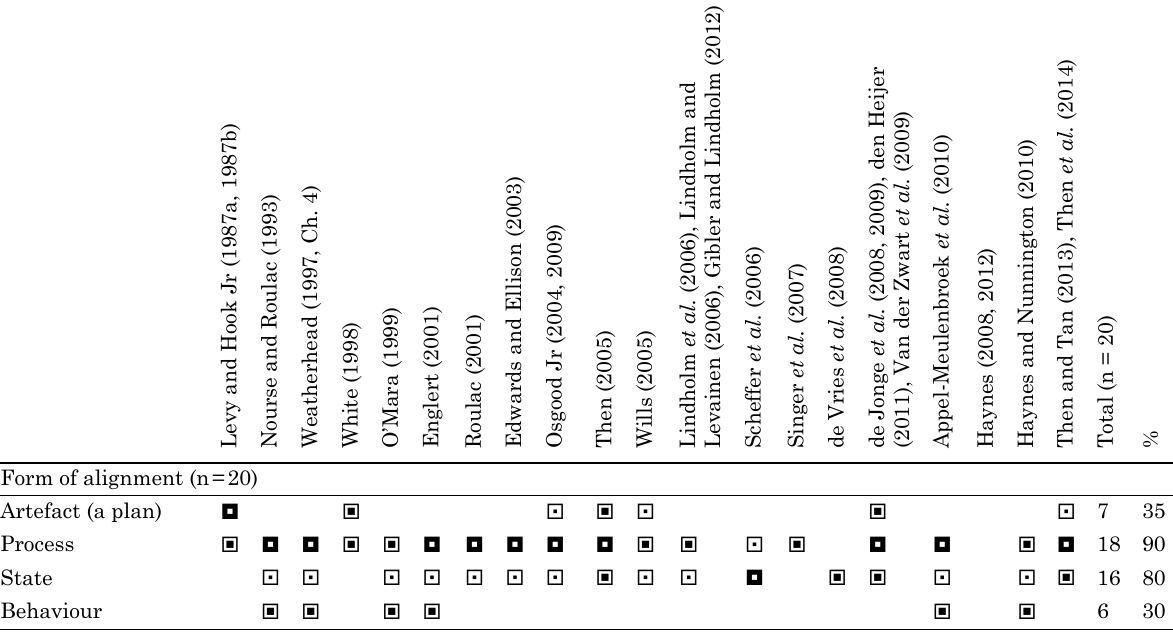
Table 3. Forms of alignment in the CRE alignment